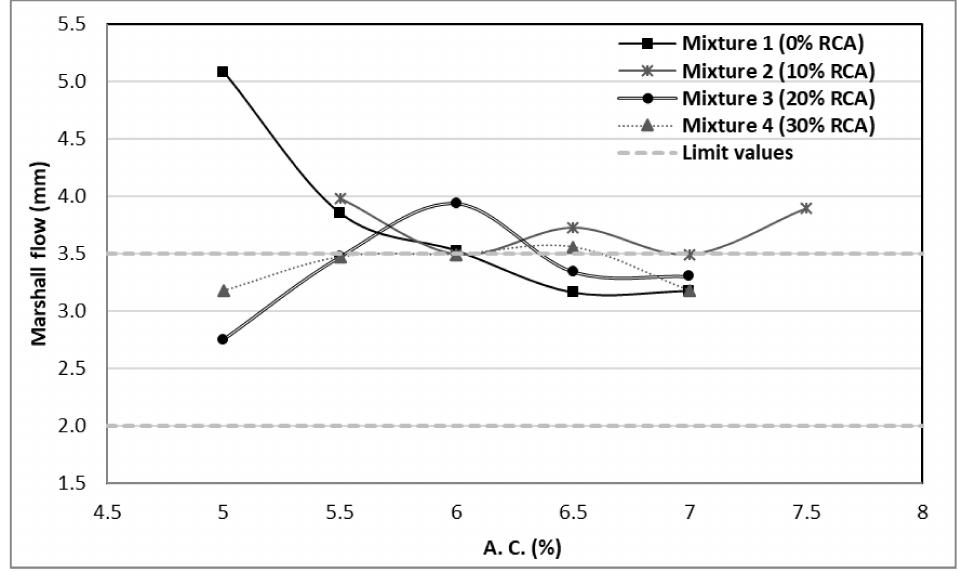
Figure 7. Flow values of the designed